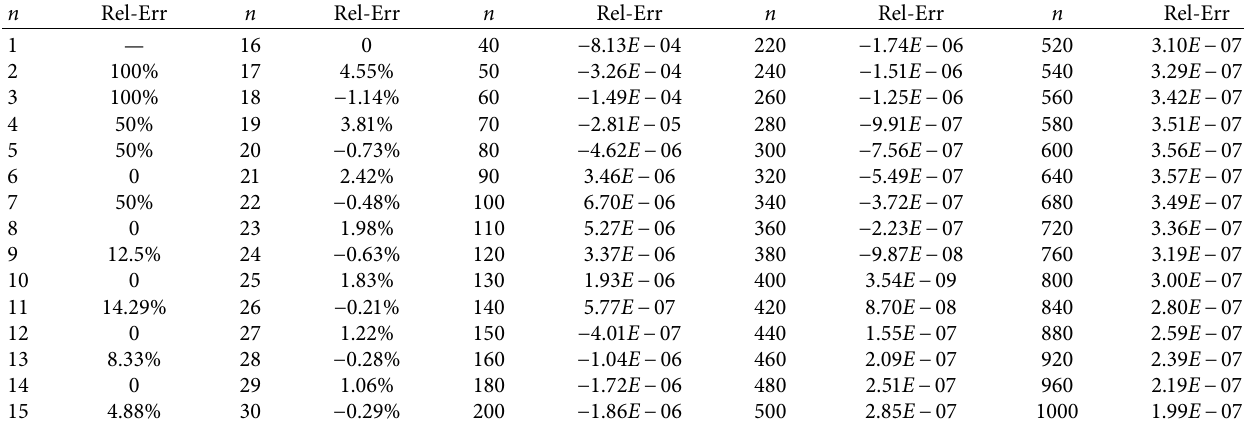
( n ) + 1/2 􏼄 􏼅 to h ( n ) when n ≤ 1000. 7 a